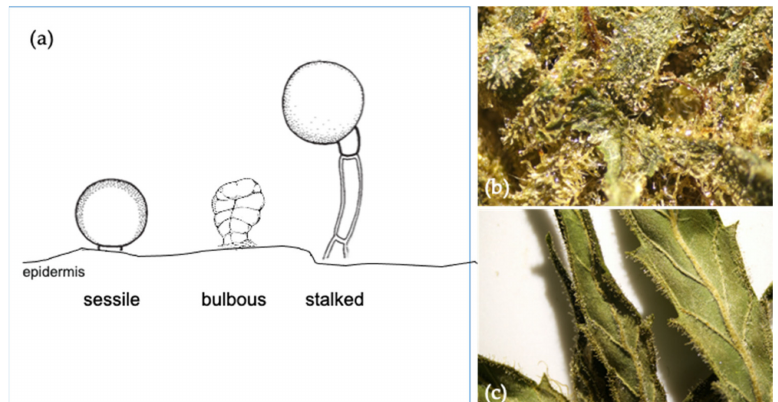
Figure 4. Di ff erent trichome structures for cannabis plants ( a ); the stalked types that are available on the floral surface ( b ); and sugar leaf structures with the presences of trichomes of the Cannabis sativa L. var. Kees’ Old School Haze ® (available at https: // dutch-passion.com) ( c